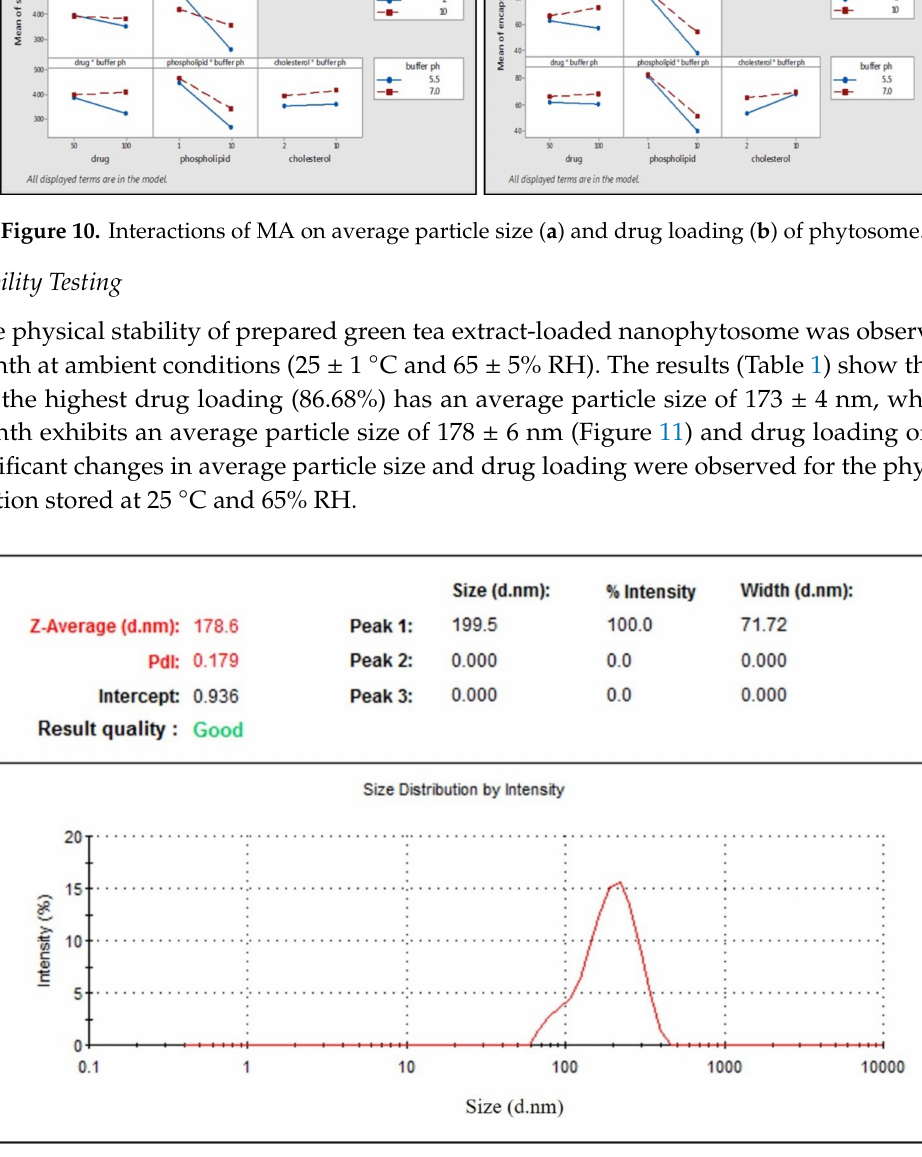
Figure 11. Particle size distribution of nanophytosome (batch 16) after one